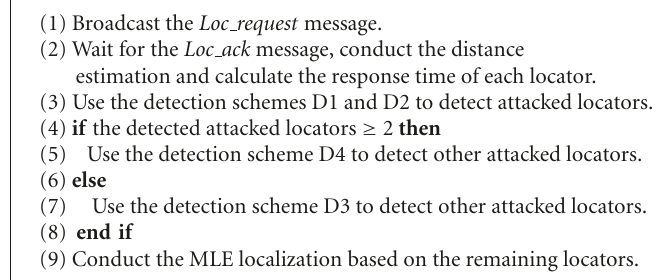
Algorithm 2: Enhanced TSCD secure localization scheme.